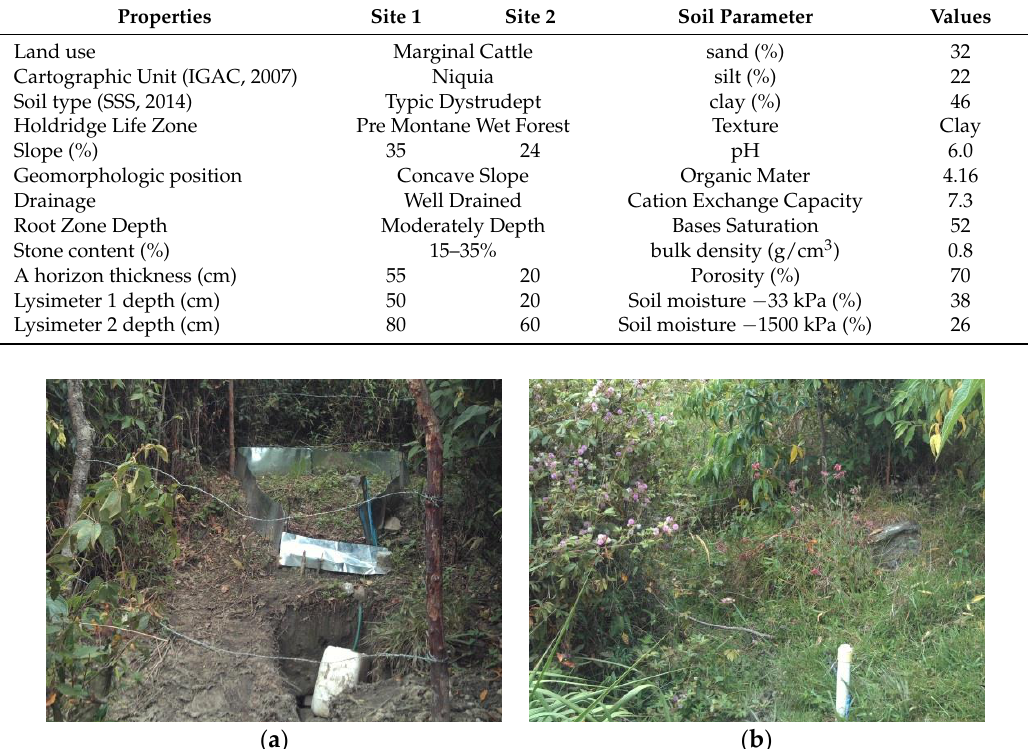
Table 1. Soil physical and chemical properties and instrumentation characteristics of the study plots. Adapted from [15].